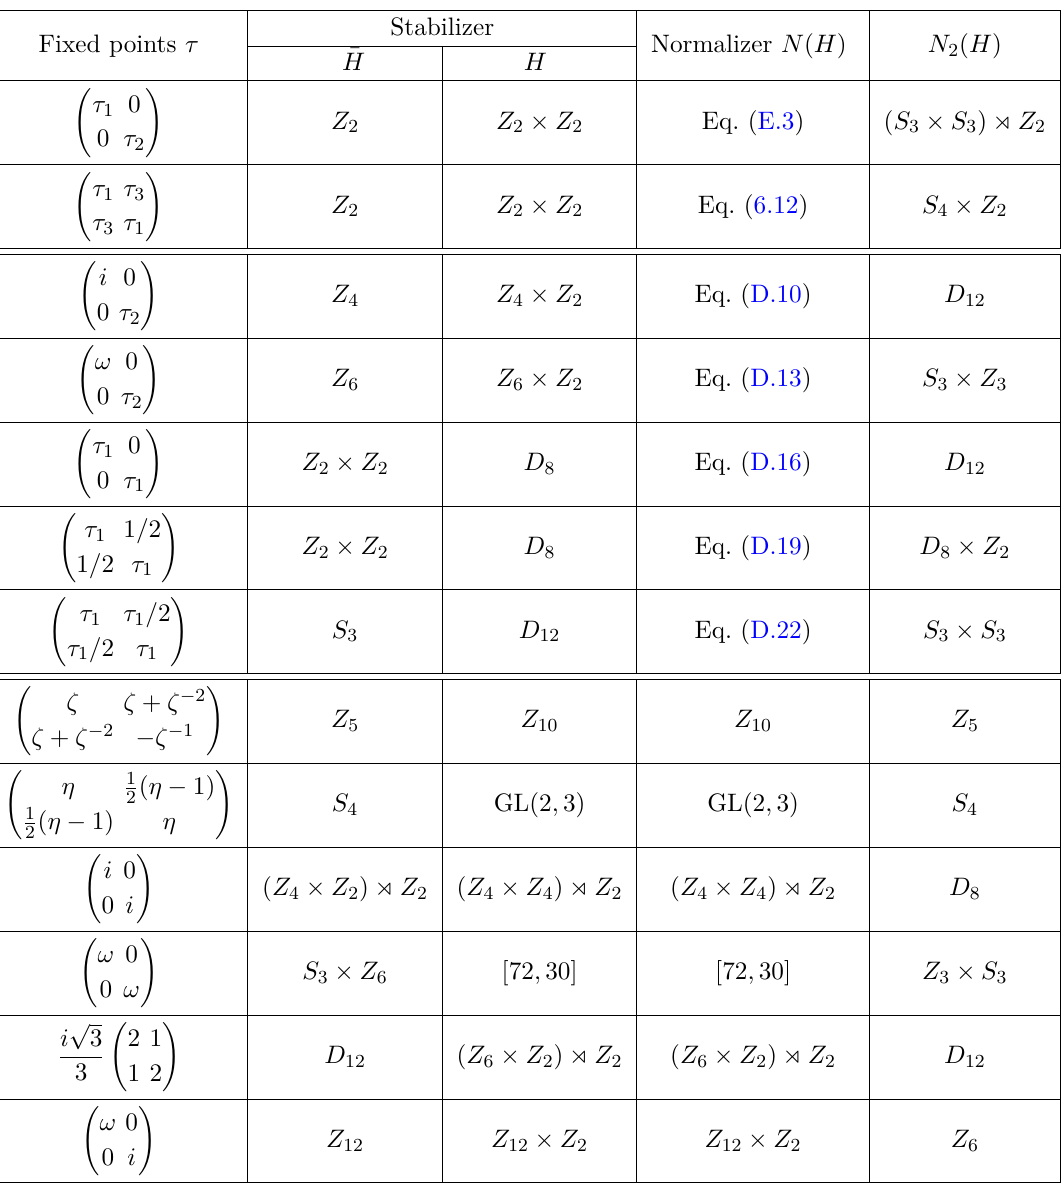
Table 2 . All inequivalent fixed points of Sp(4 , Z ) in the Siegel upper half plane H 2 . They are divided into three classes according to the dimension of the region they live in. The complex moduli are denoted by τ 1 , τ 2 , τ 3 , and ζ = e 2 πi/ 5 , η = 1